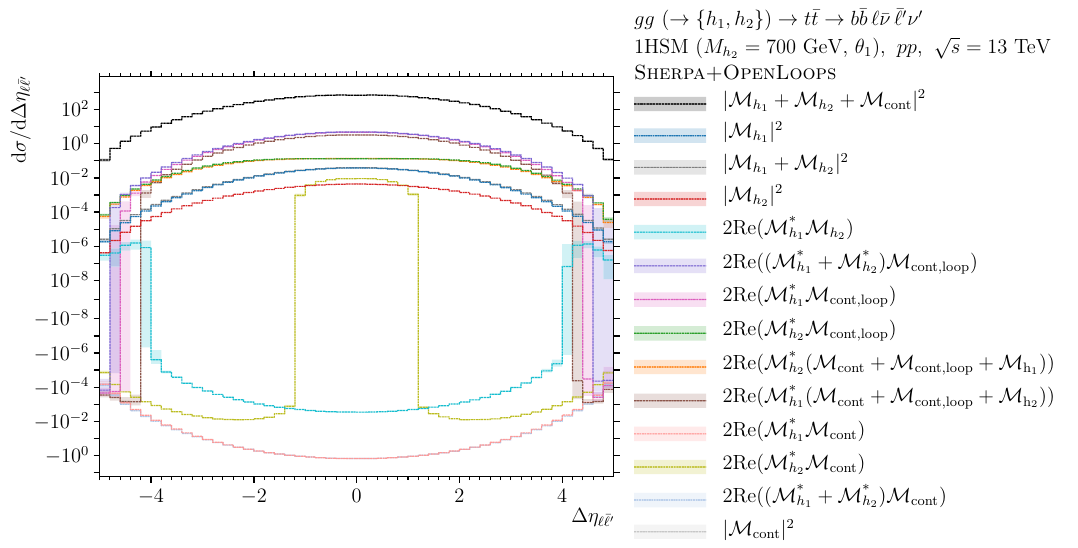
Figure 13 . ∆ η distributions for the signal process gg ( (cid:31) ¯ (cid:31) (cid:31) = 700 GeV, θ 1 ) including its interference with the background in pp collisions at the 1HSM ( M h 2 √ s = 13 TeV. Other details as in figure